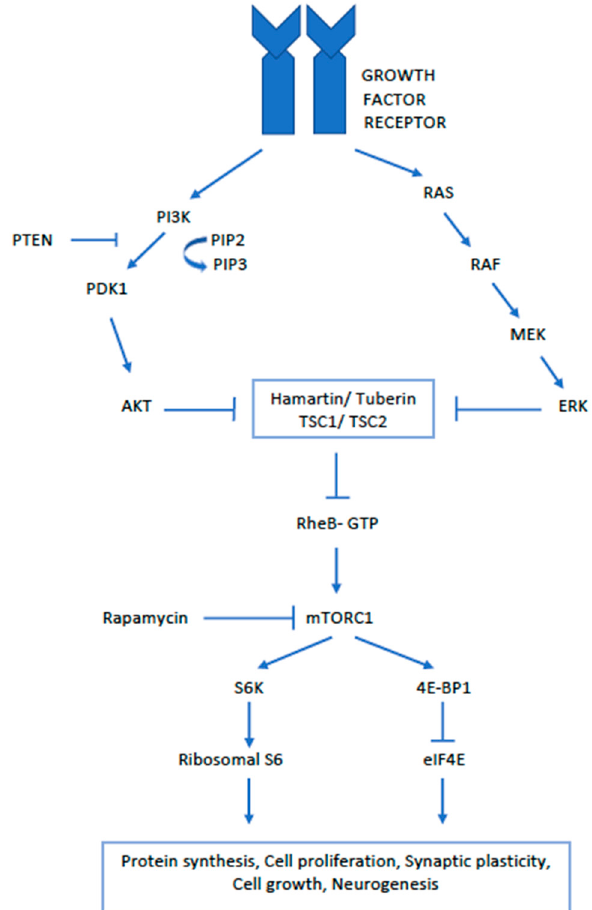
Figure 3. Schematic presentation of mammalian target of rapamycin (mTOR)-signaling pathway. The mTORC1 is activated by extracellular growth factors via two pathways: PI3K/AKT and Ras/RAF/MEK/ERK. The TSC1/TSC2 is a critical integrator for upstream signals and functions as negative regulator of mTORC1. Rapamycin is an alternative negative regulator of mTORC1. The downstream signaling consists of activation of ribosomal biogenesis and protein synthesis through S6K and eIF4E.